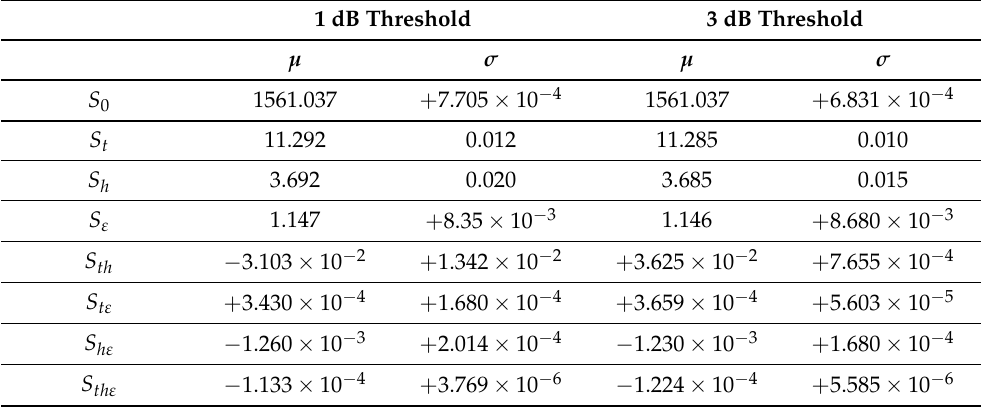
Table 8. Mean ( µ ) and standard deviation ( σ ) over the six peak detection algorithms of sensitivities calculated for 1 and 3dB thresholds.